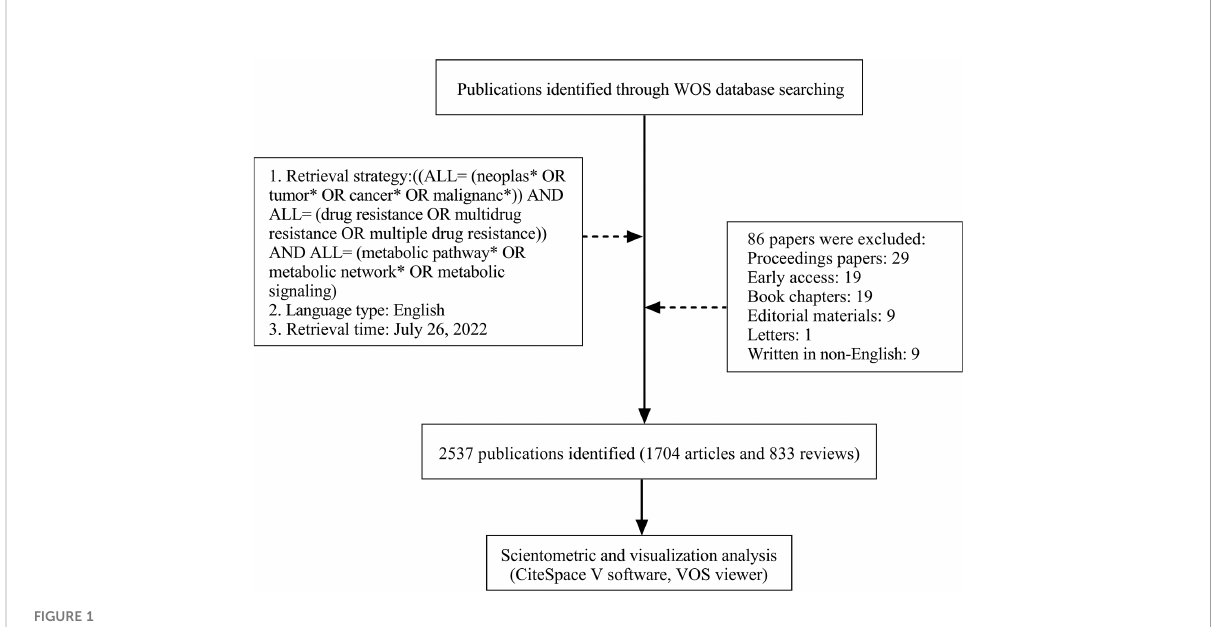
FIGURE 1 Flow chart of literature search and